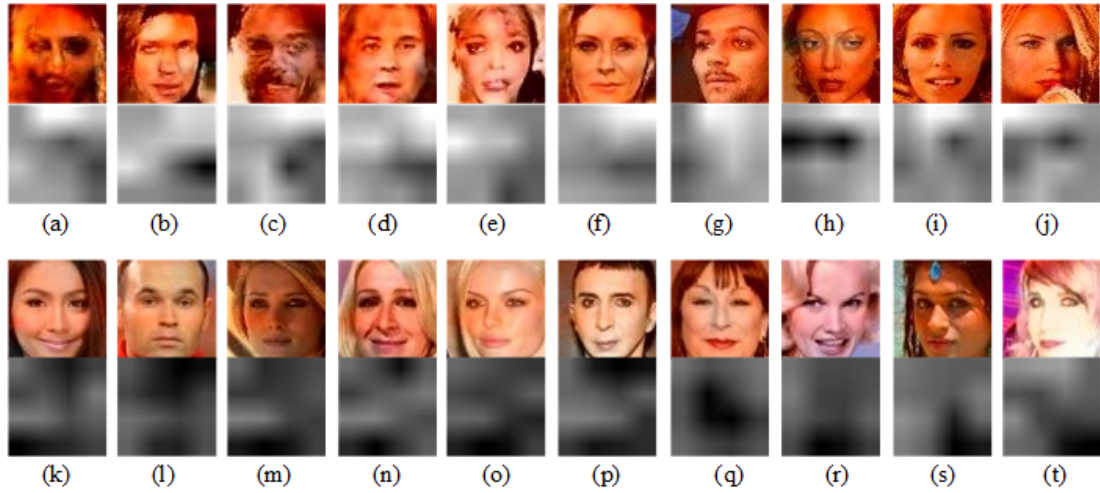
Figure 5. The visualized fake feature map for localization of fake regions in face images generated